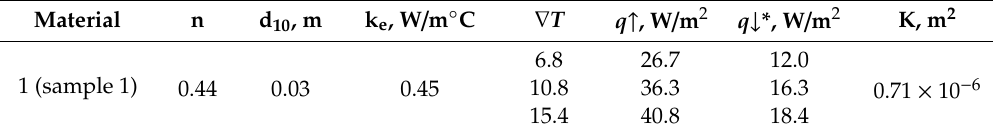
Table4. Samplecharacteristics, experimentalresultsandback-calculatedvaluesofintrinsicpermeability.